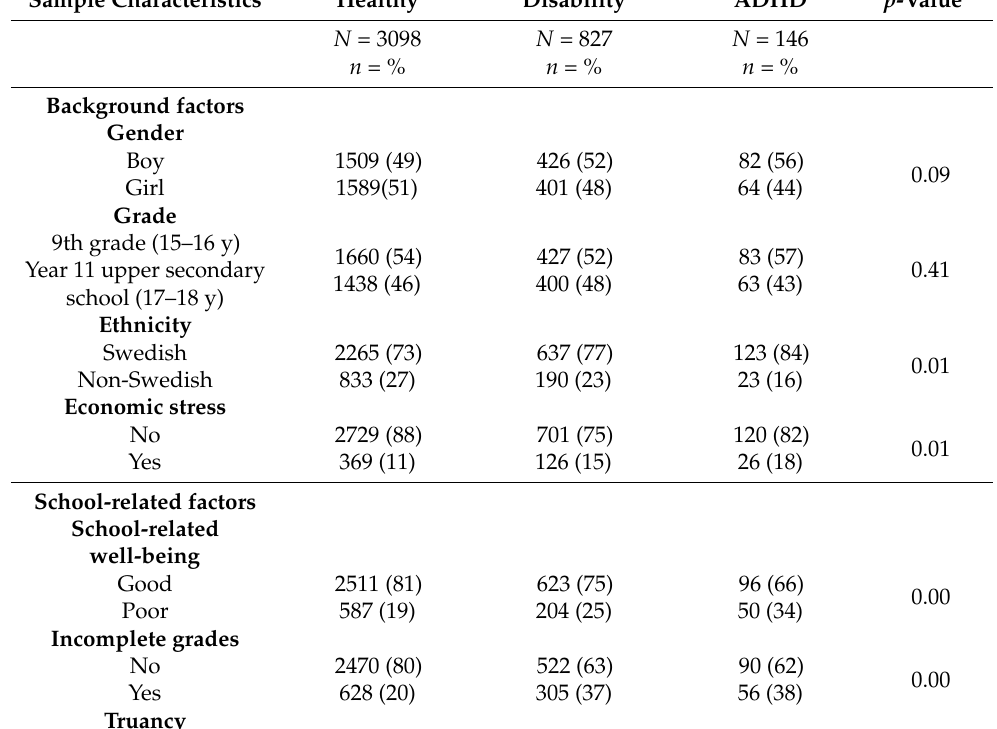
Table 1. Background factors, school-related factors and health-compromising behaviours and their association to self-reported disabilities, or